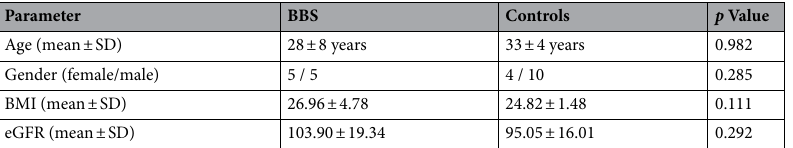
Table 1. Main features of Bardet–Biedl syndrome (BBS) patients and controls. BMI: body mass index (Kg/ m 2 ); eGFR: estimated glomerular filtration rate (ml/min/1.73m 2 ); SD: standard deviation.